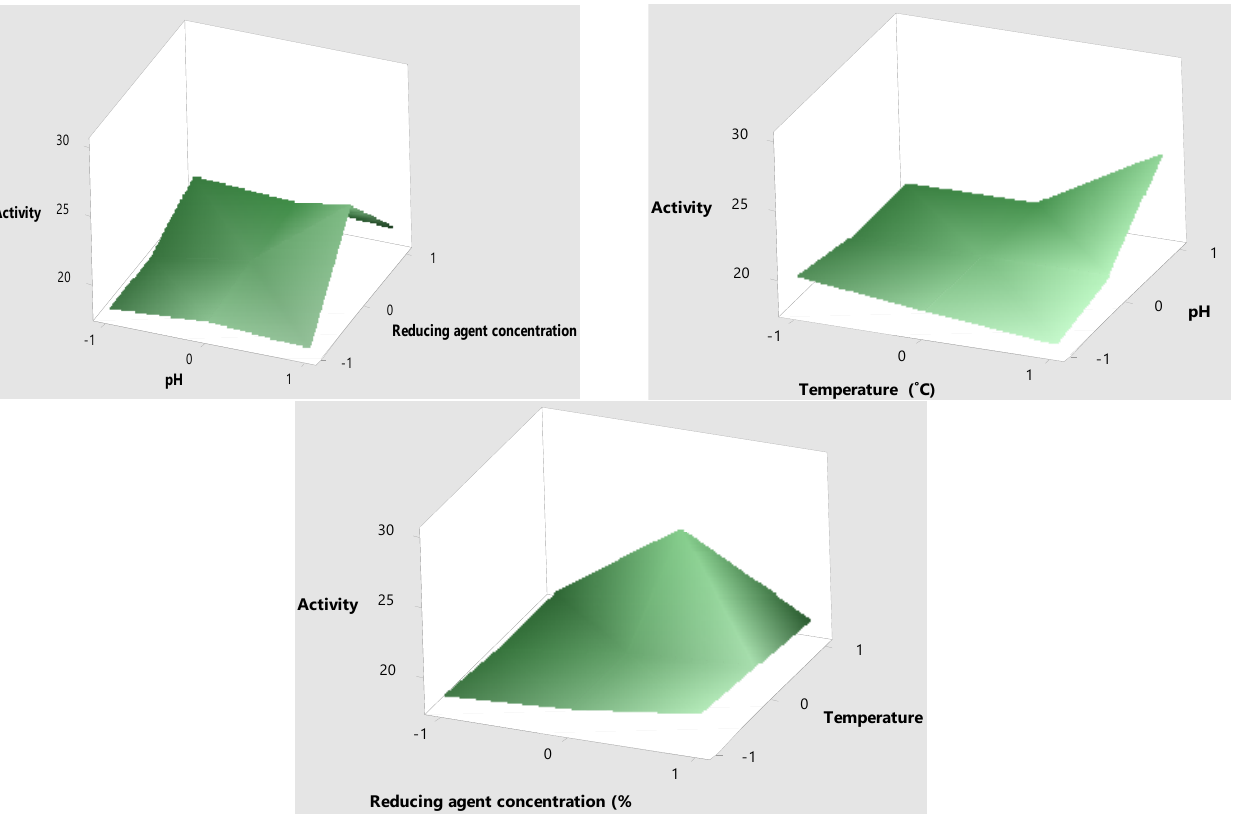
Figure 4. Three-dimensional response surface plot for Mo-capped AgNP synthesis.